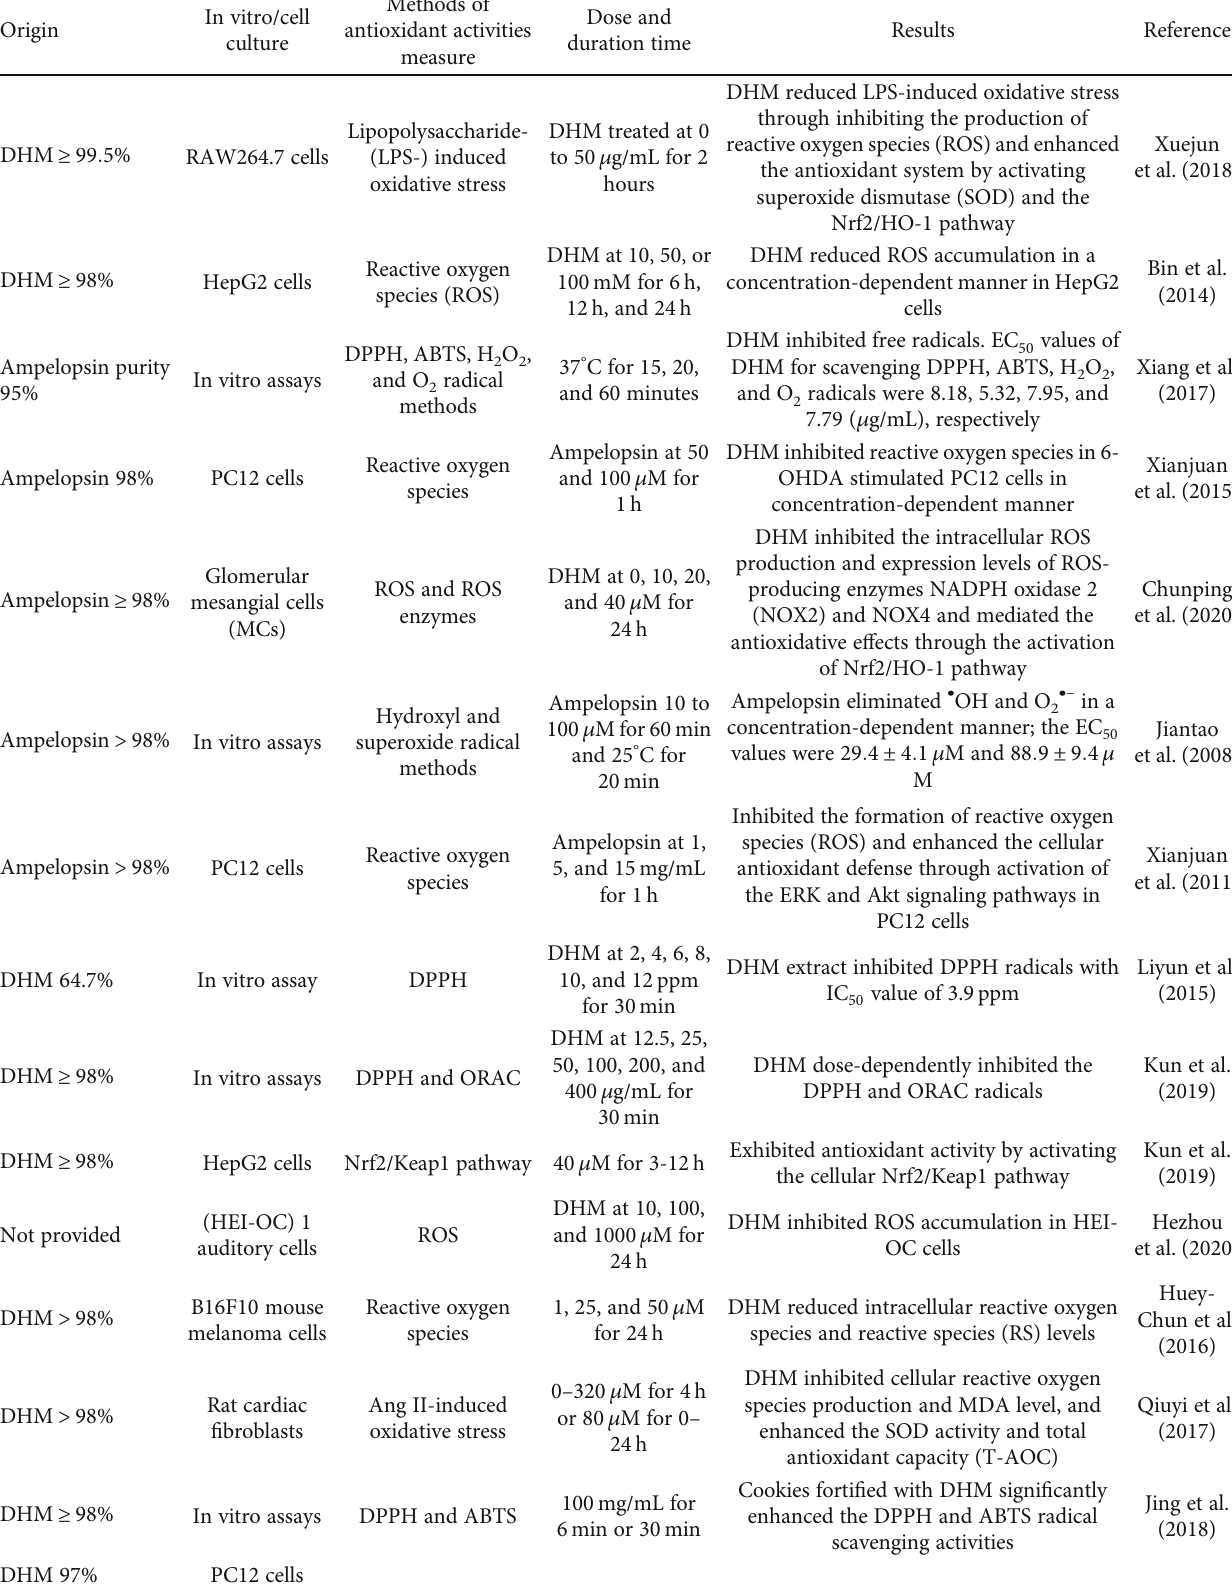
Table 2: Antioxidant activities and mechanisms of the action of